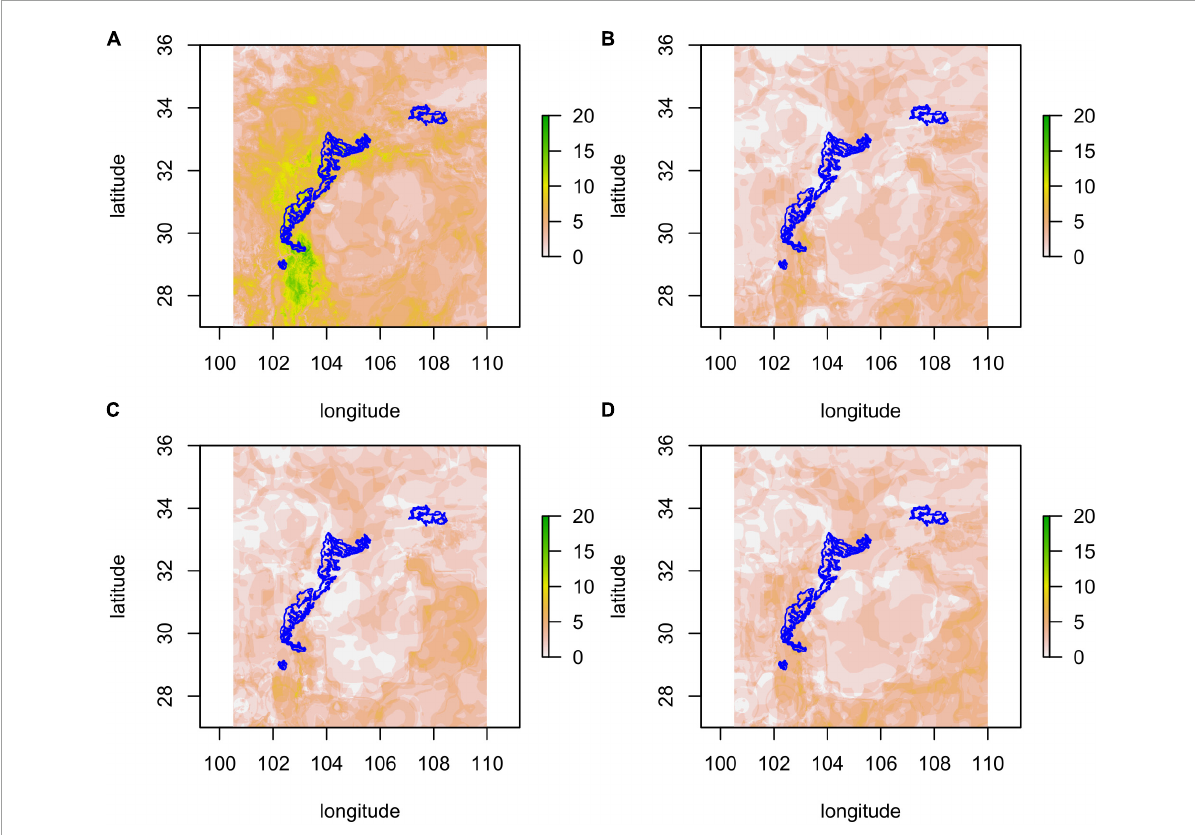
FIGURE5 Projections of suitable habitats for 40 threatened endemic species (A) at present (i.e., 1970–2000) and in 2081–2100 under climatic and land-use scenario (B) SSP3–4.5, (C) SSP3–7.0, and (D) SSP5–8.5, in overlap with the GPNP. Each map is an overlay of 40 presence-absence maps of 40 species. The color scale indicates the number of species that is expected to (co-)occur in the region. The blue contour indicates the borders of the